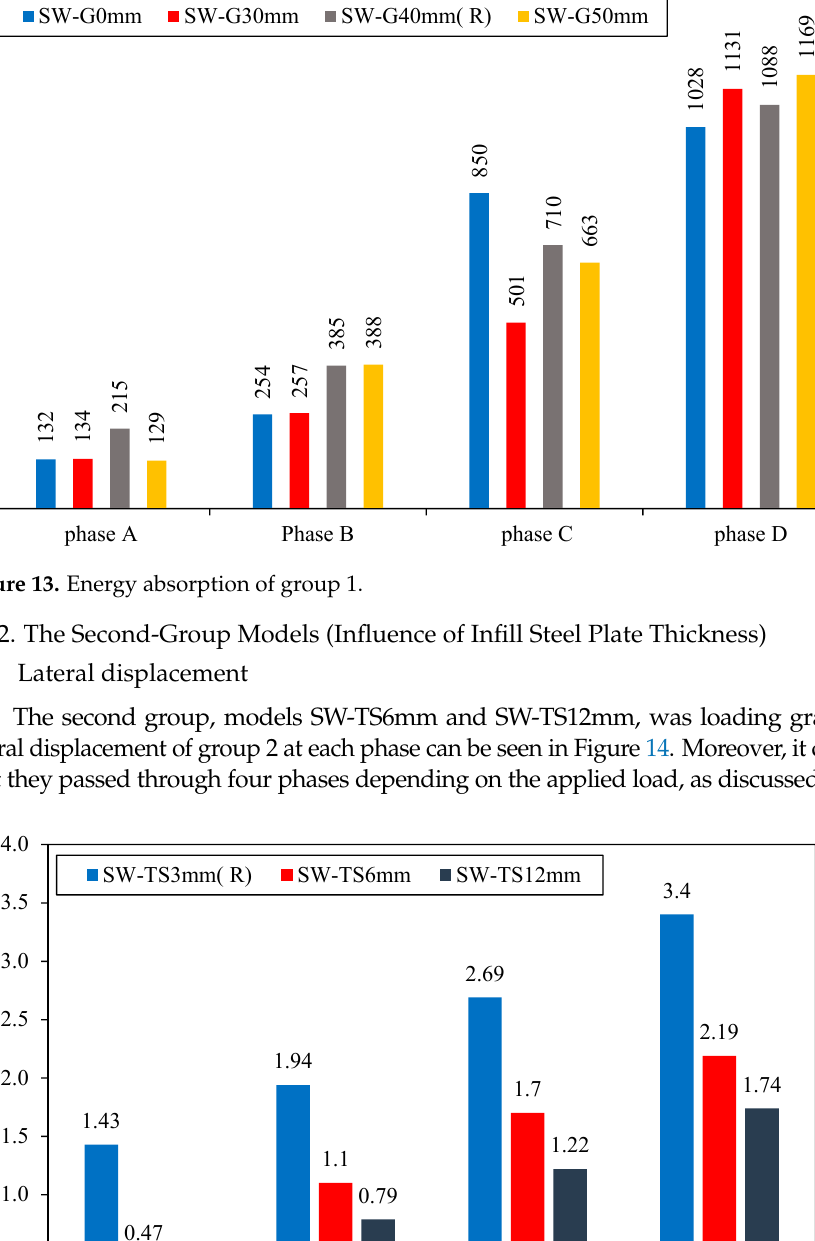
15 of 29 Figure 12. Ductility ratio of group 1. 4.